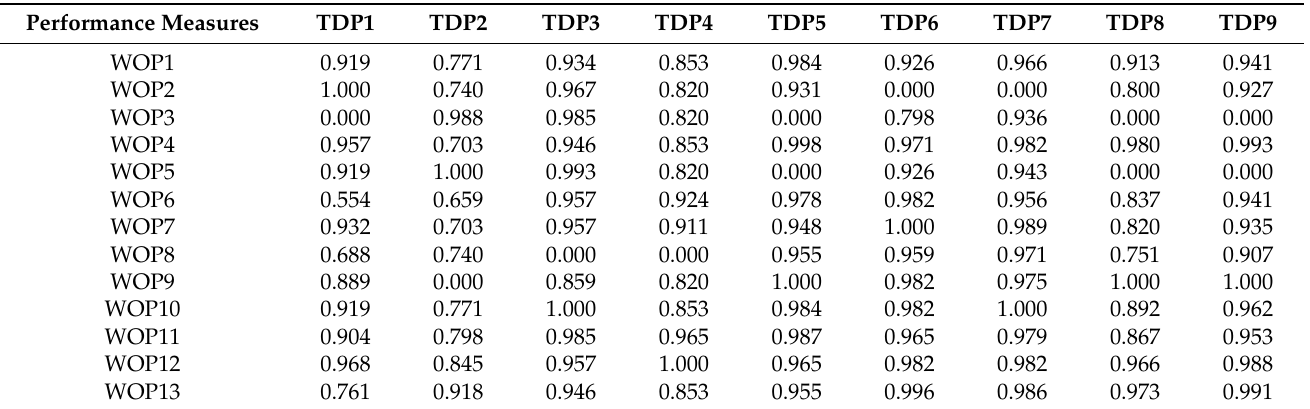
Table 12. Exponentially comparability sequence matrix.